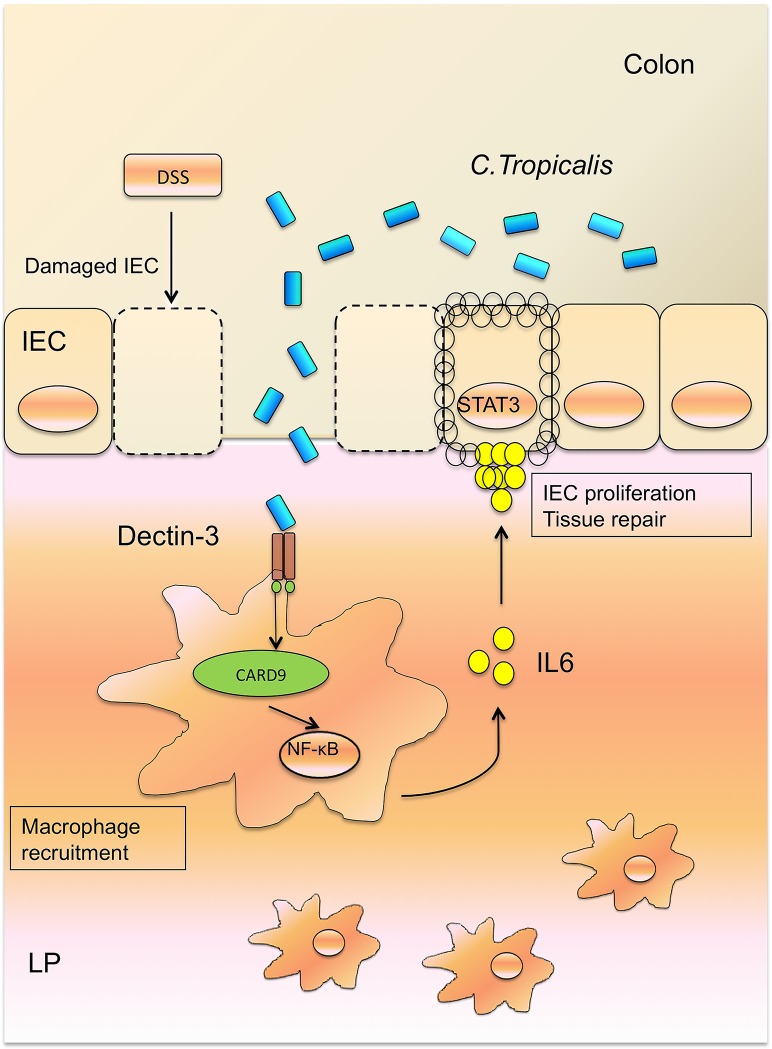
A working model summarizing the findings of this study.